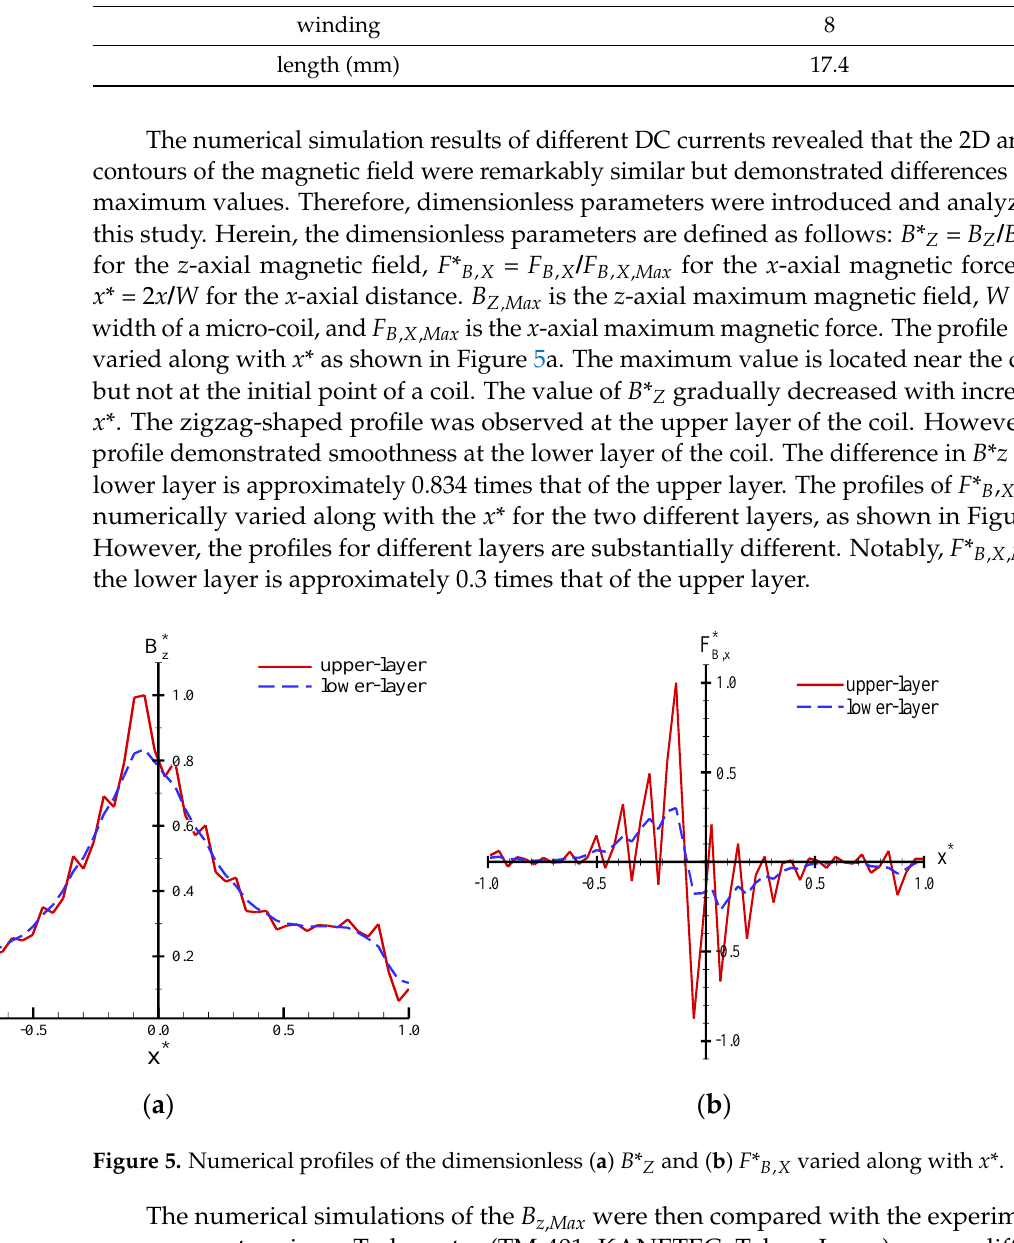
( b ) Figure 6. ( a ) Numerical and experimental results of B Z,Max and ( b ) calculations of F B,X,Max versus different DC currents. The numerical simulations of the B z ,Max were then compared with the experimental measurements using a Tesla meter (TM-401, KANETEC, Tokyo, Japan) versus different applied currents, as shown in Figure 6a. The simulation and experiment results of Bz, Max quasi-linearly varied with the applied DC currents for the planar coil. Additionally, the numerical simulations are in reasonable agreement with the experimental measurements. The deviation between the numerical calculations and experimental measurements was less than 18.5%. Similarly, the F B, x ,Max was then calculated as displayed in Figure 6b. The F B, x ,Max results also presented linear proportions with the different DC currents. 3.2. Thermal Characterizations The temperature effect is a crucial issue for magnetic actuation. Elevated tempera- ture cannot be immediately reduced, thus decreasing the efficiency of the magnetic ma- nipulation or damaging biosamples. The 3D steady-state heat conduction equation can be expressed as: